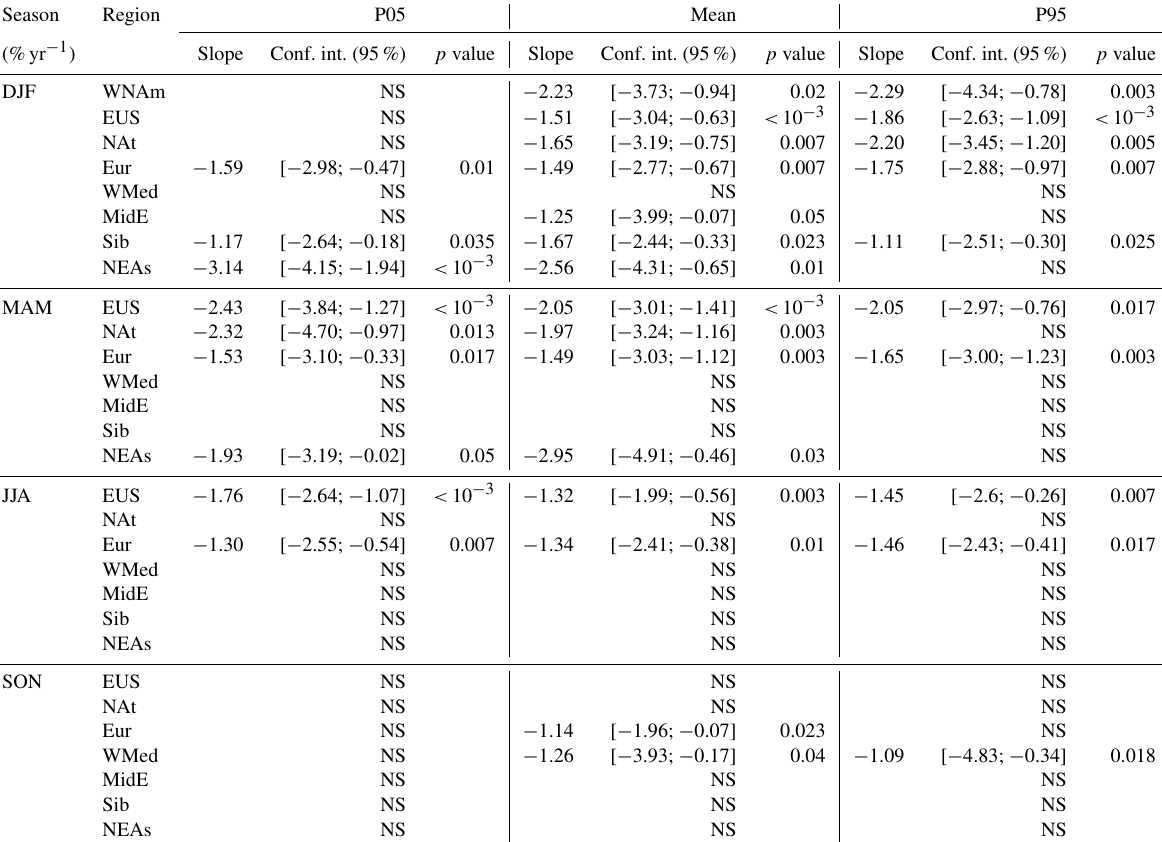
Table D8. CO relative trends in %yr − 1 during each season in the UT. From left to right, the anomalies are taken from deseasonalized P05, monthly means, and P95. The insignificant trends with respect to the 95% confidence level are indicated as NS. Note that the trends in northwest America are available only in